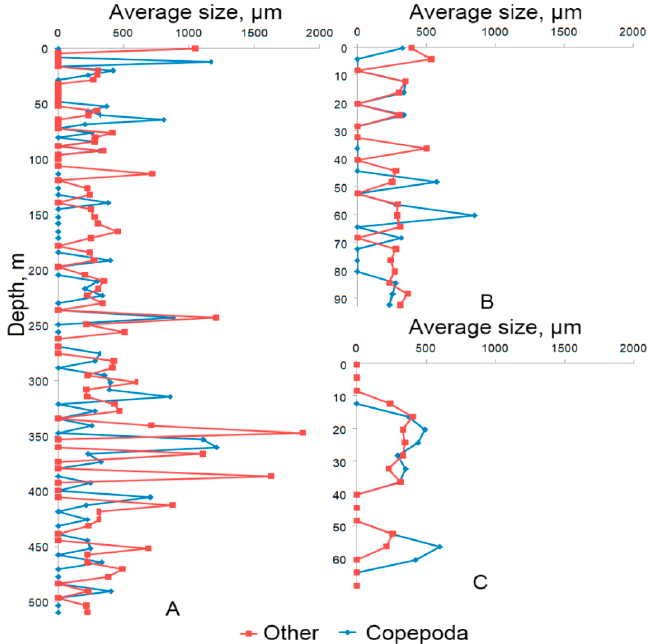
Figure 11. Average particle size by stations: ( A ) Station no. 6 with submersion up to 500 m and geographical coordinates 44°31.2398 ′ N 37°54.3828 ′ E; ( B ) Station no. 5 with submersion up to 100 m and coordinates 44°32.0743 ′ N 37°55.3762 ′ E; ( C ) Station no. 4 with submersion up to 70 m and co- ordinates 44°32.1922 ′ N 37°56.0360 ′ E.